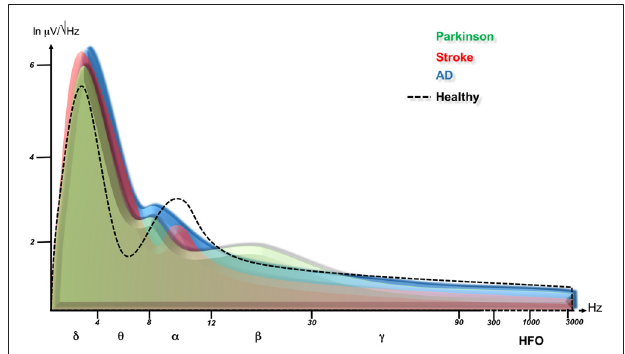
FIGURE 3 | Cortical oscillation changes in neurological disorders. This figure is a summary of published data and shows power spectra after Fast Fourier Transformation are superimposed for healthy subjects (dashed line), Parkinson disease (green, Jenkinson and Brown, 2011; Melgari et al., 2014), stroke (affected hemisphere (AH), red, Tecchio et al., 2005; Graziadio et al., 2011; Assenza et al., 2013b) and Alzheimer disease (blue, Babiloni et al., 2013a,b). Note that neurological disorders cause an increase of slow rhythms, possibly as an attempt to overcome the dysfunction through cortical network synchronization. Degenerative diseases downshift the alpha frequency peak corresponding to a worsening of cognitive performance. Parkinson disease shows a specific beta rhythm increase consistent with an anti-kinetic condition, while the stroke hemisphere produces a reduction of rapid oscillations (alpha, beta, gamma) paralleling with motor performance. Please see the text of the manuscript for more